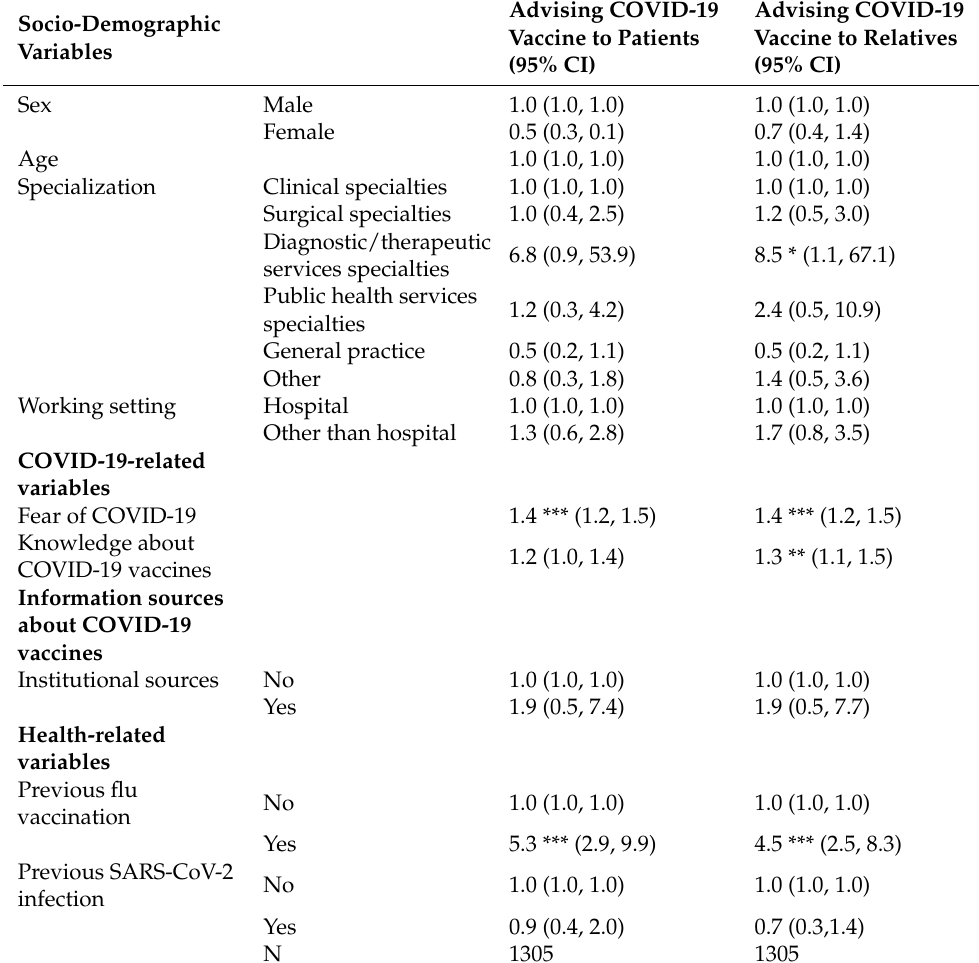
Table 5. Multivariable logistic analysis: